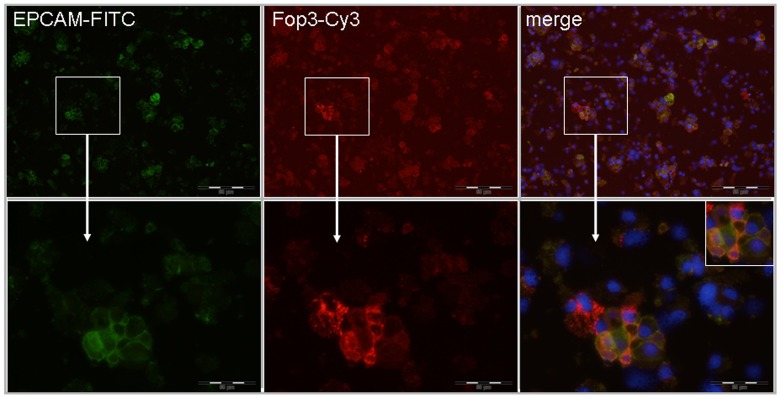
Immunofluorescence double staining of Foxp3 and EPCAM in cancer cells from patients with CRC.Representative example of an immunofluorescence double staining, showing Foxp3 expression and EPCAM costaining in cancer cells of patients with CRC (×100 magnification above; ×400 magnification below). FITC, green Fluoresceinisothiocyanate, Cy3, indocarbocyanin red and DAPI 4′,6-Diamidino-2- phenylindoldihydrochlorid blue – nuclear counterstaining.